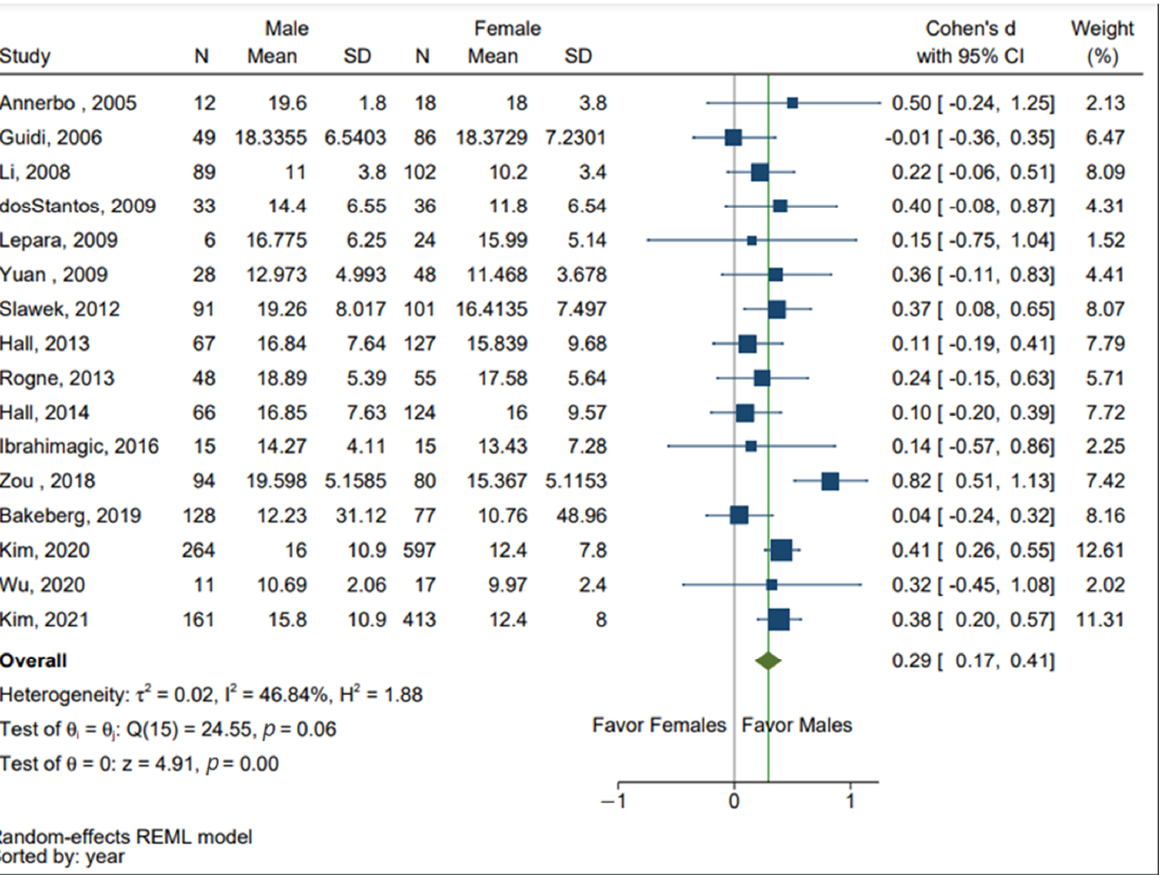
Figure 2. Forest plot displaying standardized mean differences (SMDs) or Cohen’s d in the concentration of Hcy in males (positive values) and females (negative values), 95% confidence intervals (CIs). The square symbols ( ■) represent the SMD in each study, with the size of the symbol being proportional to the precision of the estimate and the error bars indicating the 95% CI. The diamond symbol ( ♦ ) is the estimated overall effect. This plot is based on data presented in all 16 papers identified as eligible for this meta-analysis [4,10,12,22–34].